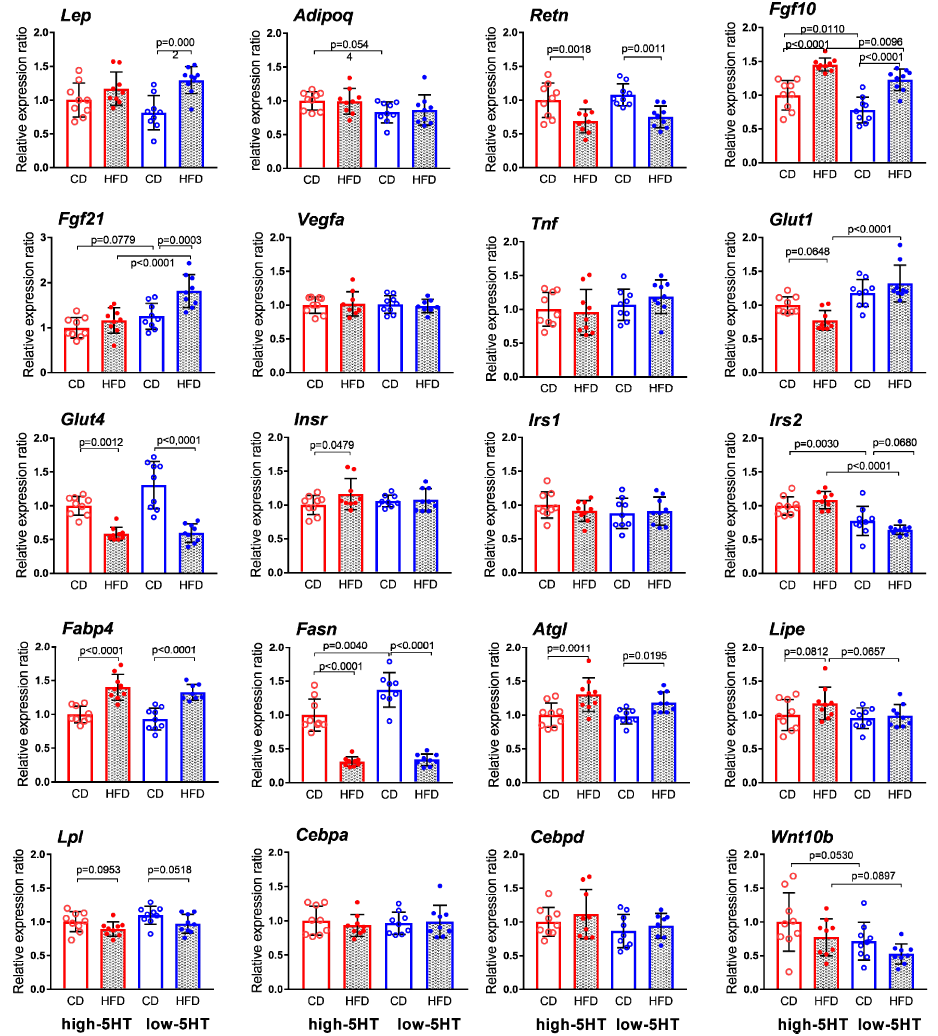
Figure 9. mRNA expression of selected weight-related molecules in gonadal white adipose tissue in animals from 5HT-sublines after 11 weeks on high-fat diet (HFD) or control diet (CD). Expression levels were normalized to the mean of two reference genes (Actb and Gapdh) and are shown as relative expression ratios between groups, with high-5HT animals receiving control diet set at 1.0. Data are presented as means ± SD; N = 9 rats per group; p -values obtained by LSD or Dunn’s post-hoc test after 1w-ANOVA or KW test, as appropriate are indicated.